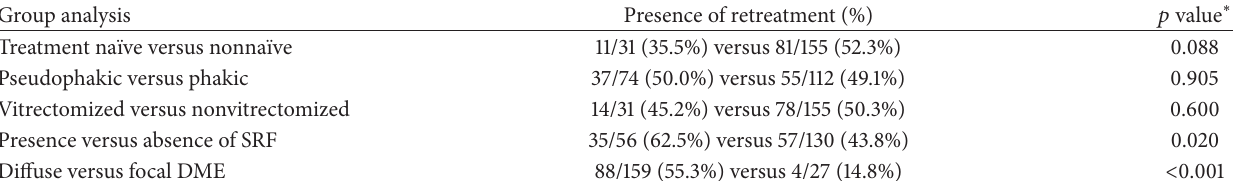
Table 2: Comparison of the retreatment rates by group analysis.